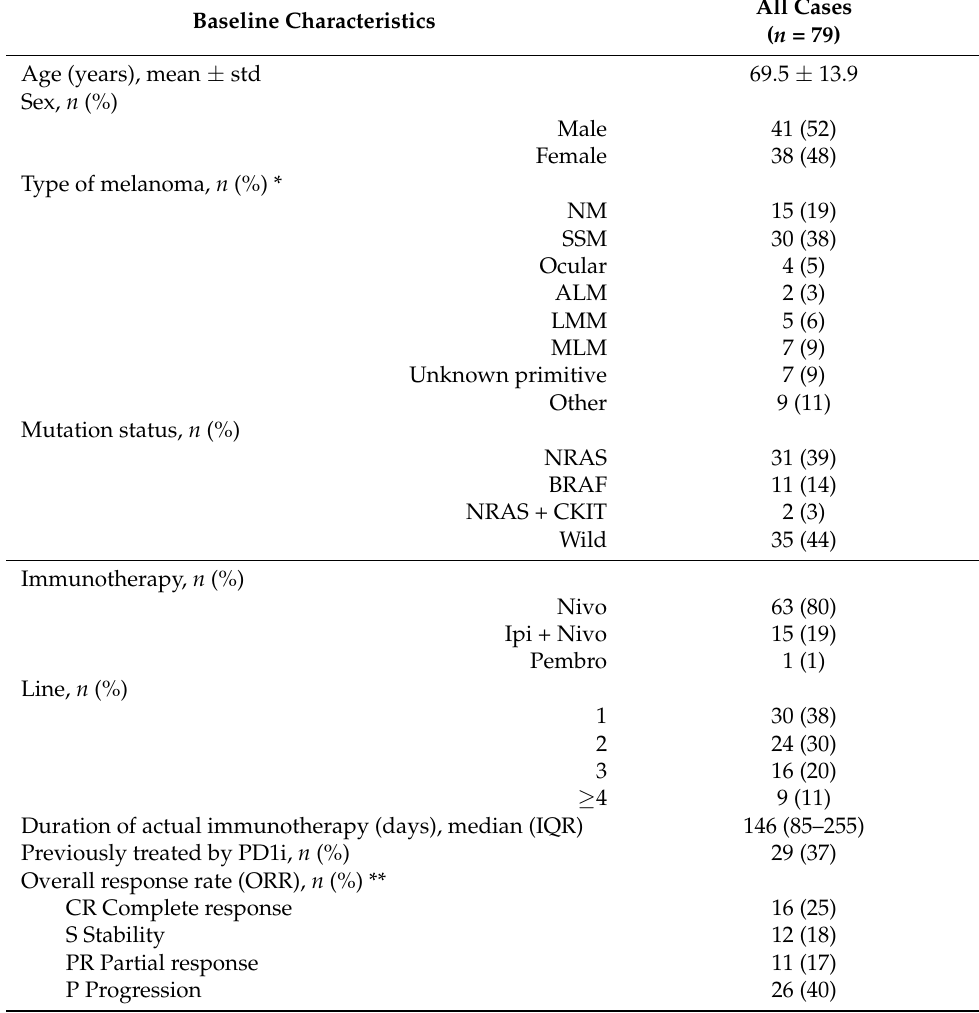
Table 1. Patient